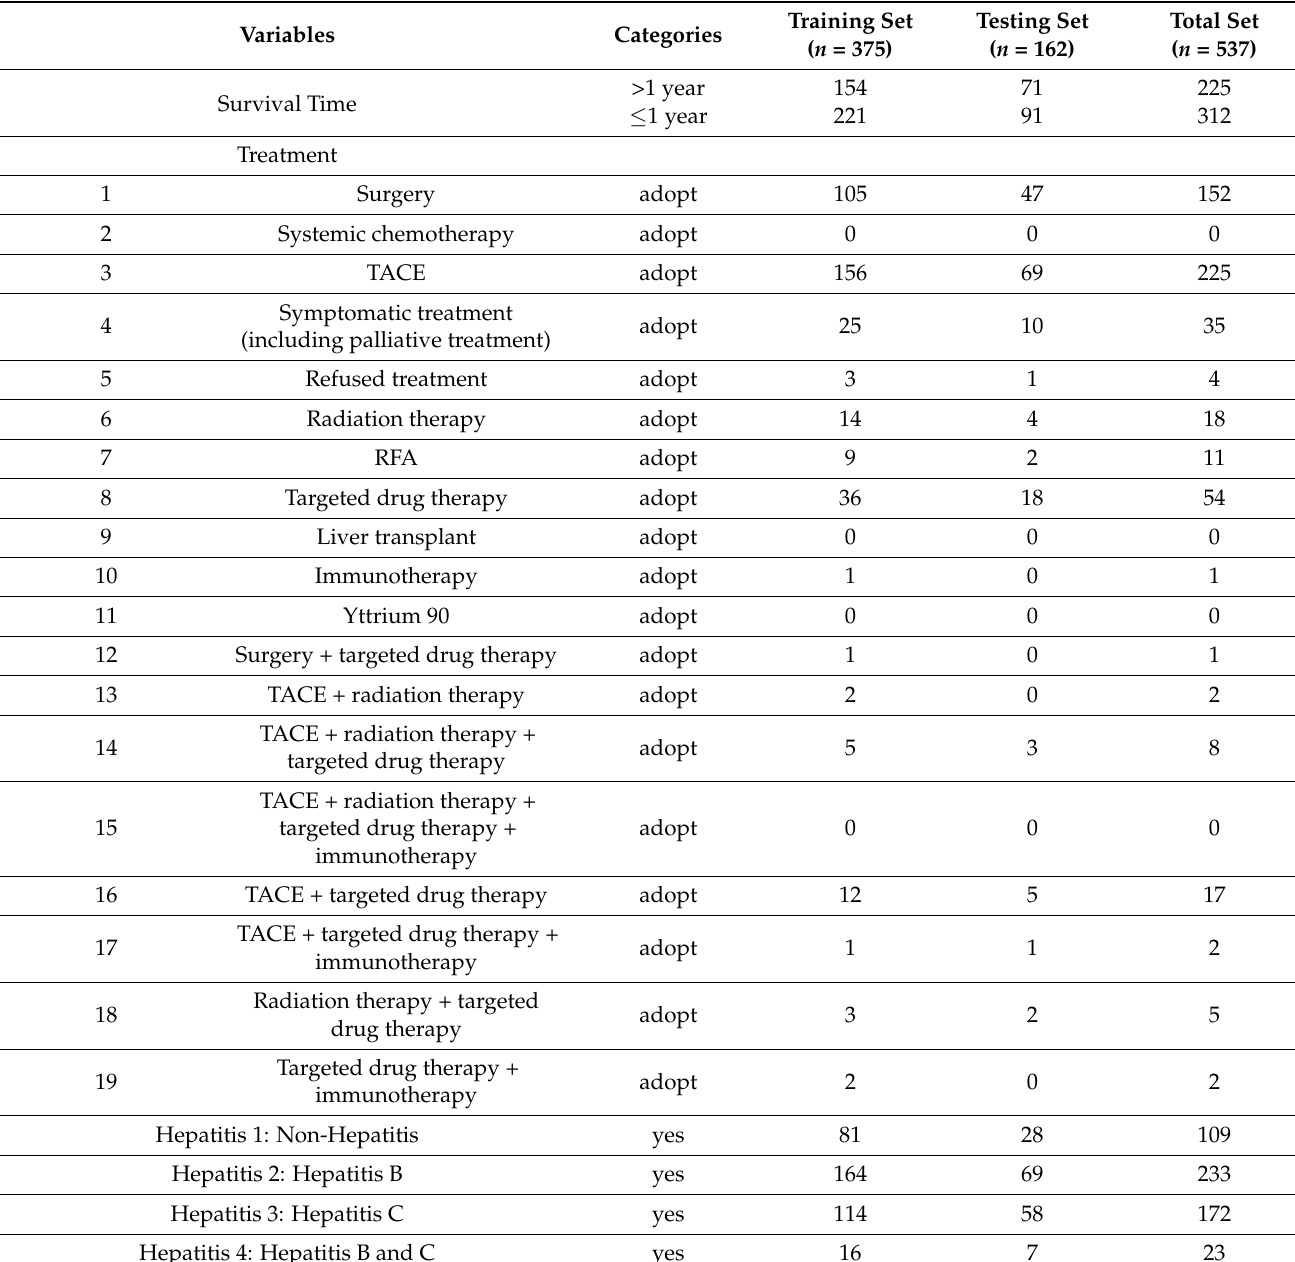
Table 1. The Distribution of Categorical